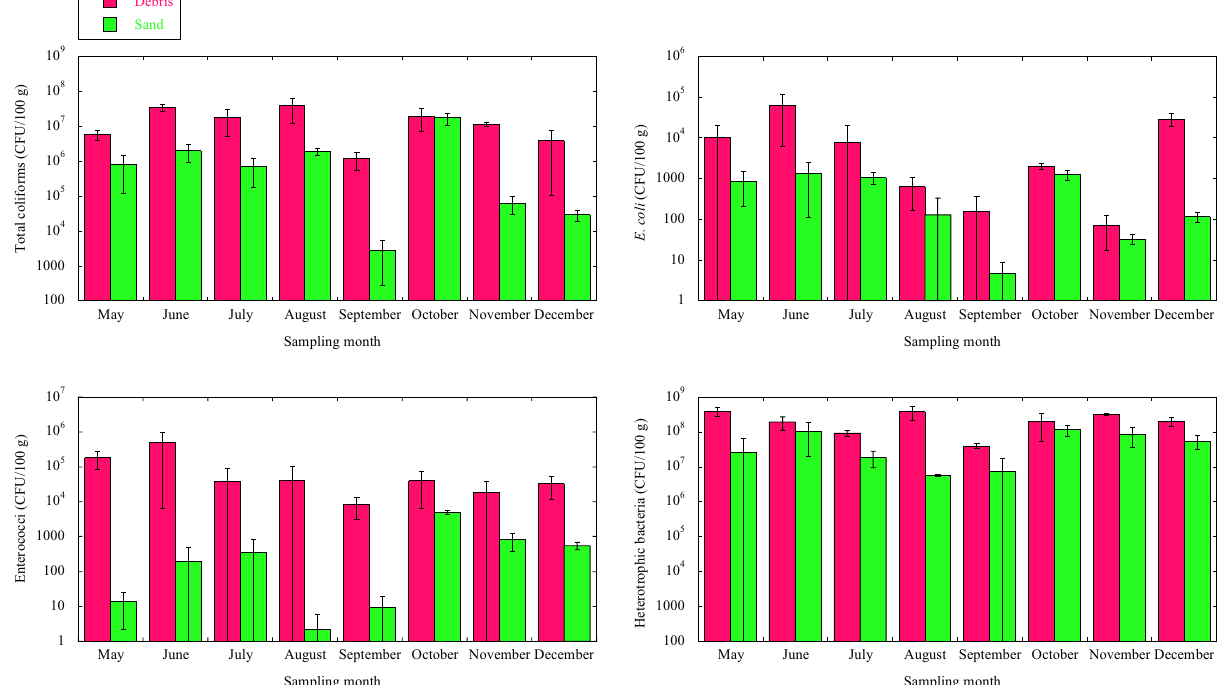
Figure 3. The changes in the numbers of total coliforms, E. coli , enterococci, and heterotrophic bacteria in the plant debris and the sand under the debris, during the entire survey period. Data are expressed as means ± standard deviations. ND, none